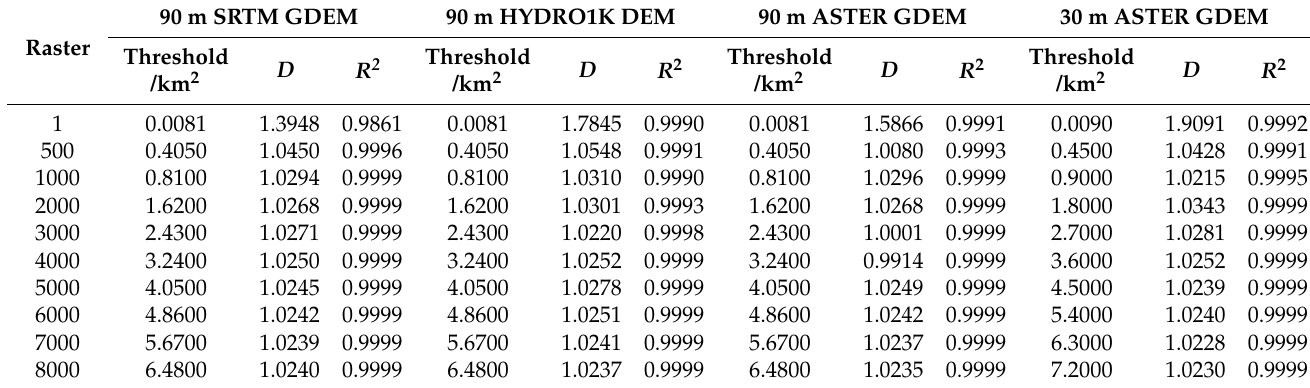
Table 2. The coefficients of each of the three DEM at the set